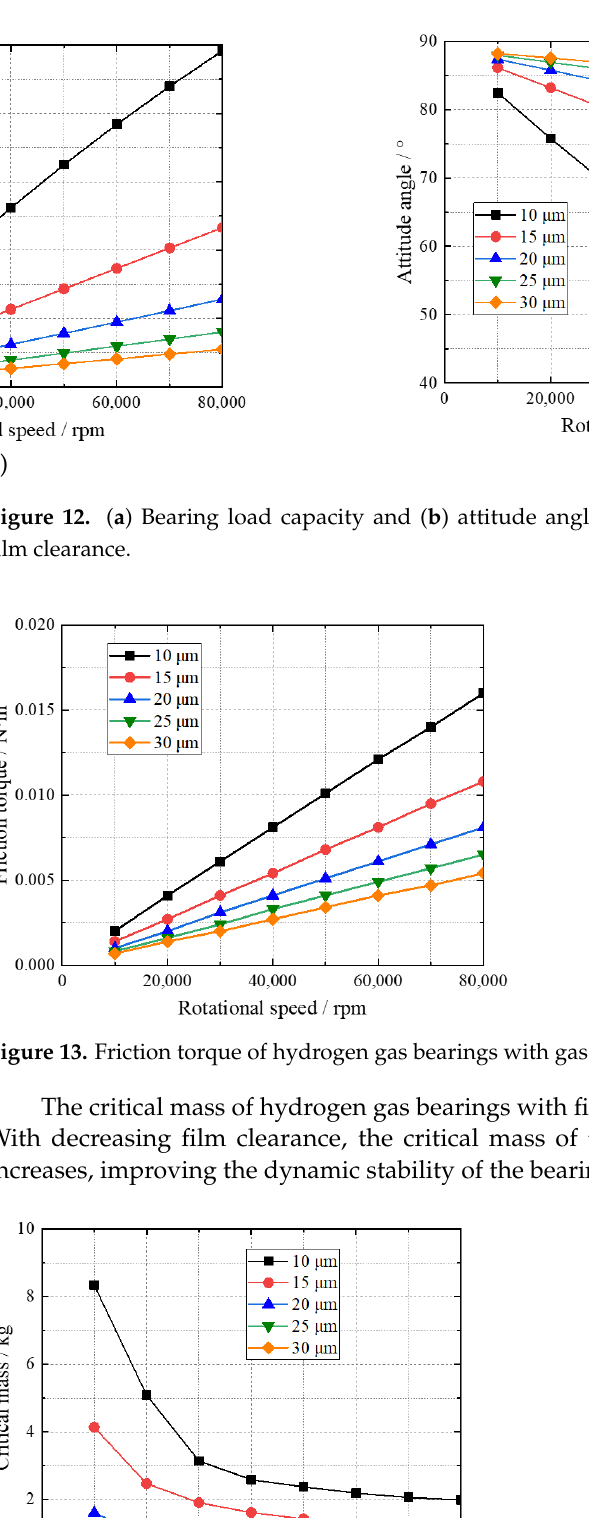
Figure 14. Critical mass of hydrogen gas bearings with gas film clearance.